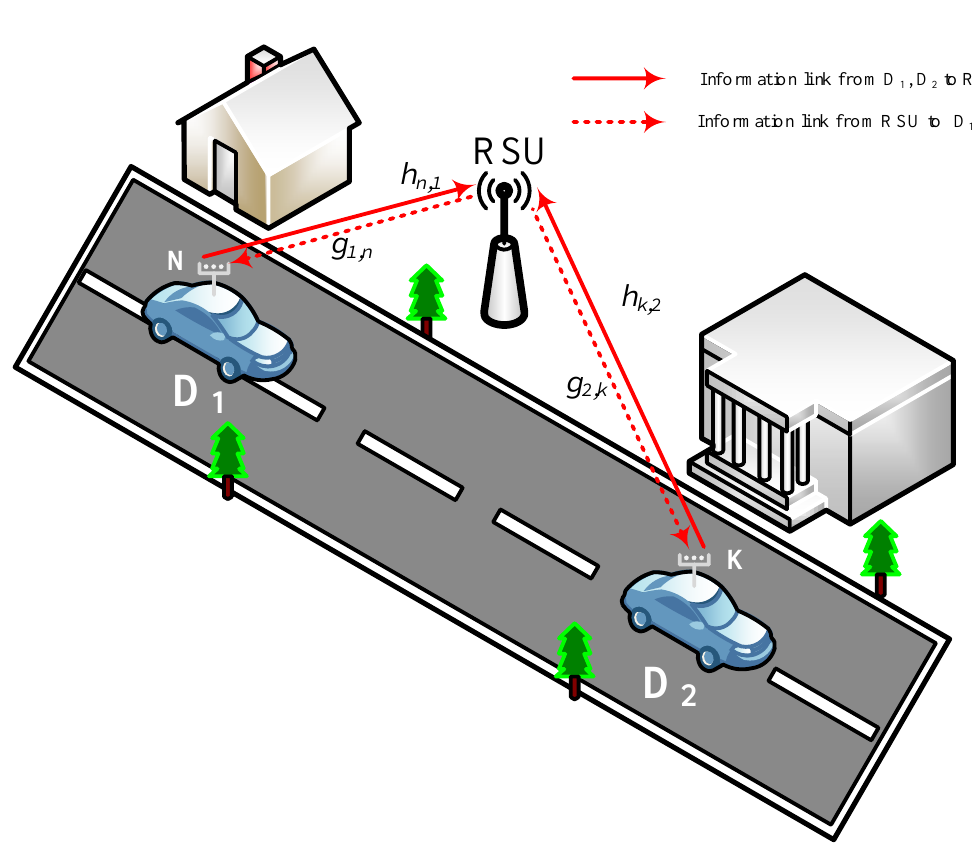
Figure 1. System model of Non-orthogonal multiple access (NOMA)-based vehicle-to-everything (V2X)